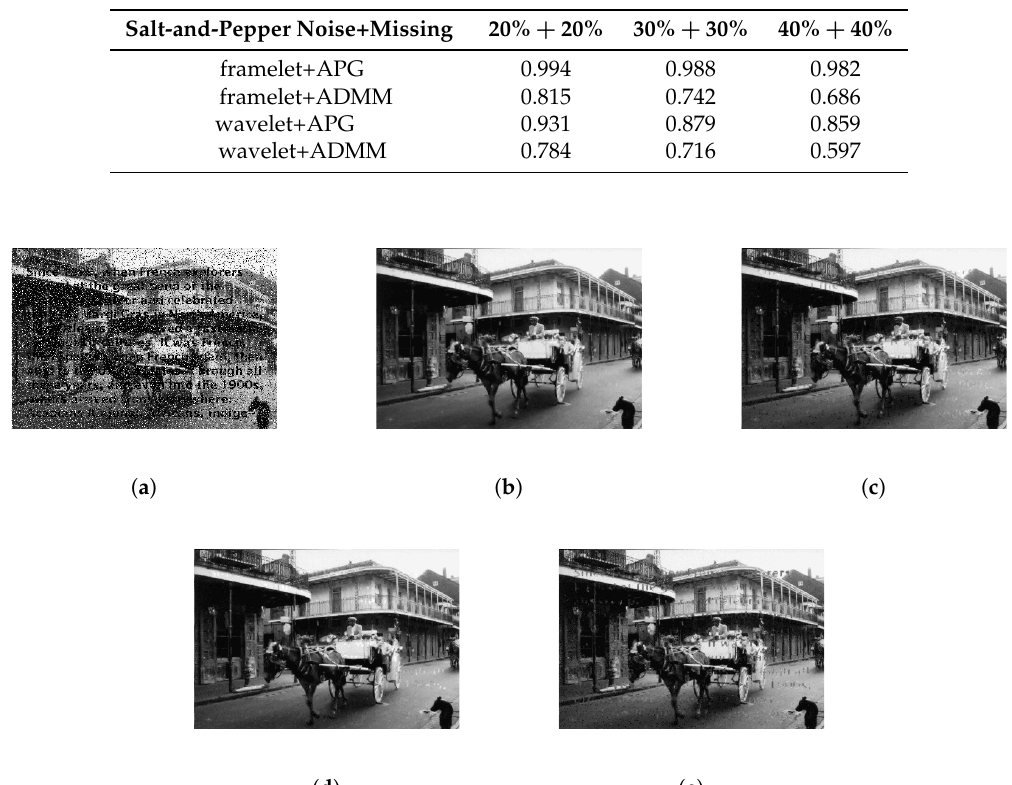
Figure 12. Restoration results of different algorithms under both salt-and-pepper noise and specific data missing. ( a ) corrupted image with 20% salt-and-pepper and 21.4% specific missing; ( b ) reconstructed image obtained by framelet+APG; ( c ) reconstructed image obtained by framelet+ADMM; ( d ) reconstructed image obtained by wavelet+APG; ( e ) reconstructed image obtained by